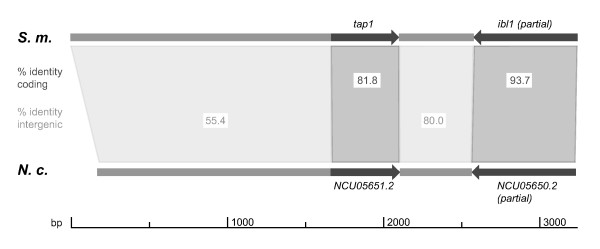
Synteny between S. macrospora (S.m.) and N. crassa (N.c.) in the genomic region containing tap1. Coding regions are given as dark gray and intergenic regions as light gray boxes. Nucleic acid identities between the S. macrospora open reading frames and their N. crassa orthologues as well as between the intergenic sequences are indicated.